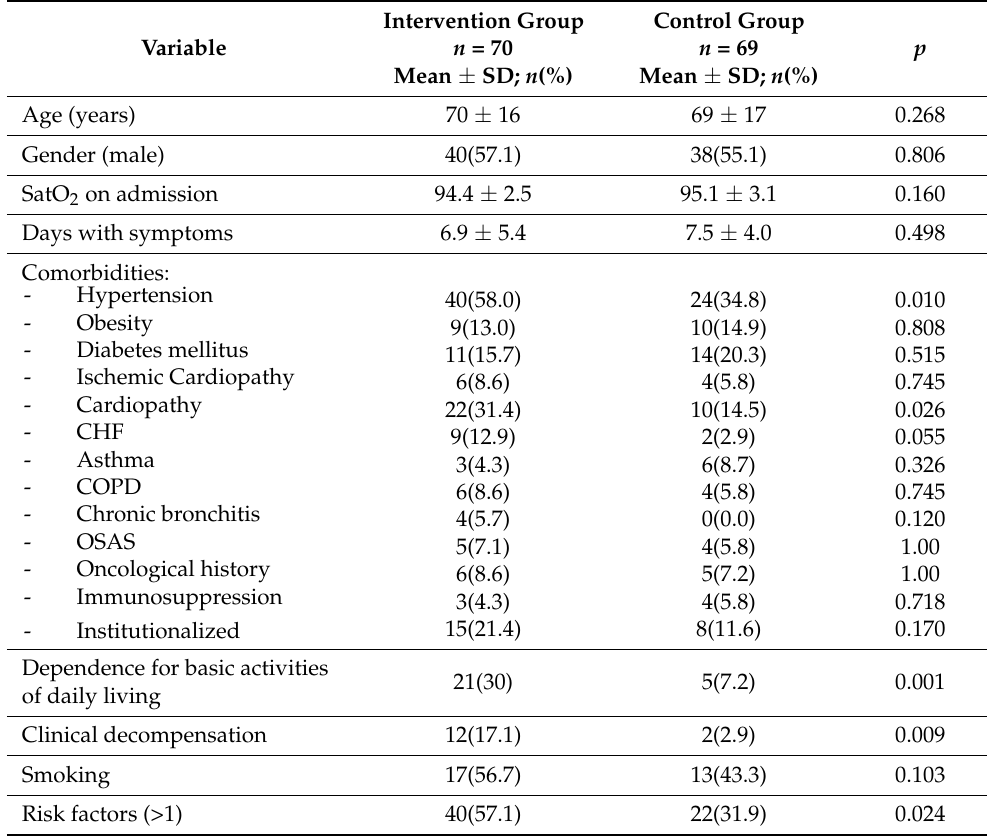
Table 1. Summary of the clinical characteristics of the study survival population. The p -values were obtained with the X 2 test and Student’s t -test. Abbreviations: SD, standard deviation; CHF, congestive heart failure; COPD, chronic obstructive pulmonary disease; OSAS, obstructive sleep apnea syndrome; * Risk factor is defined as the presence of at least one comorbidity.